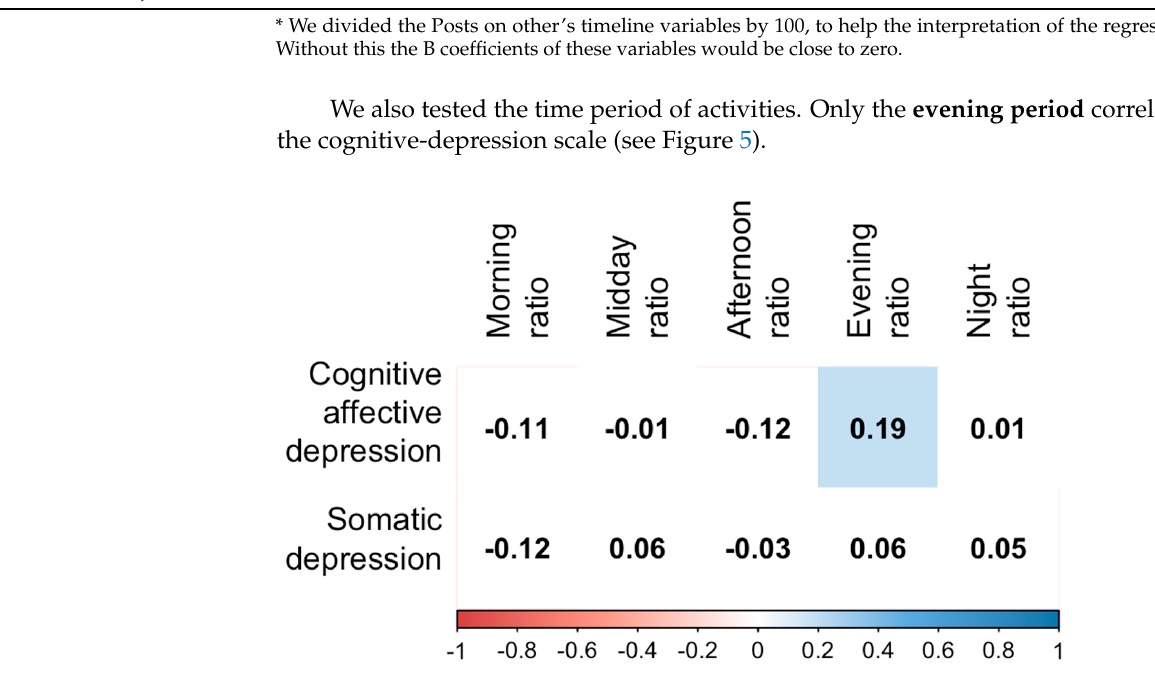
Figure 5. Pearson correlation between within day activity indicators and depression indicators.